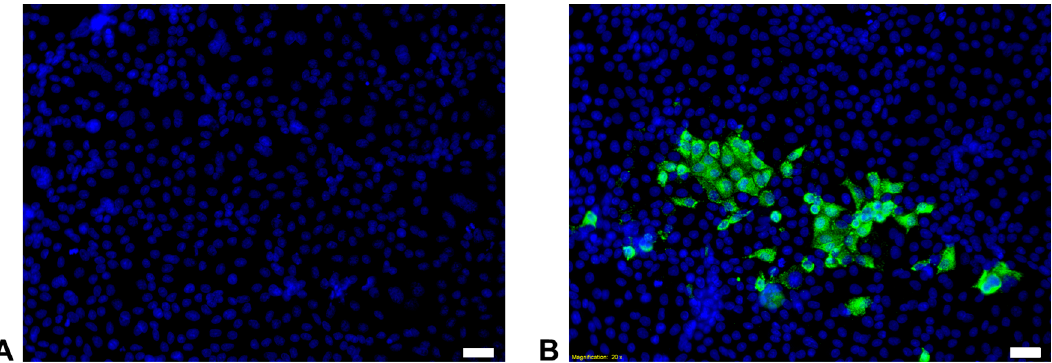
Figure 1. Isolation of FeMV-GT2-Gordon strain on LLC-MK2 cells. Five days post infection passage no. 3 was stained with a FeMV-nucleoprotein-specific antibody (shown in green). Images were taken at 200-fold magnification. Cell nuclei are stained in blue. ( A ) Mock infection; ( B ) Infection with FeMV-GT2. Scale bars represent 20 µm.